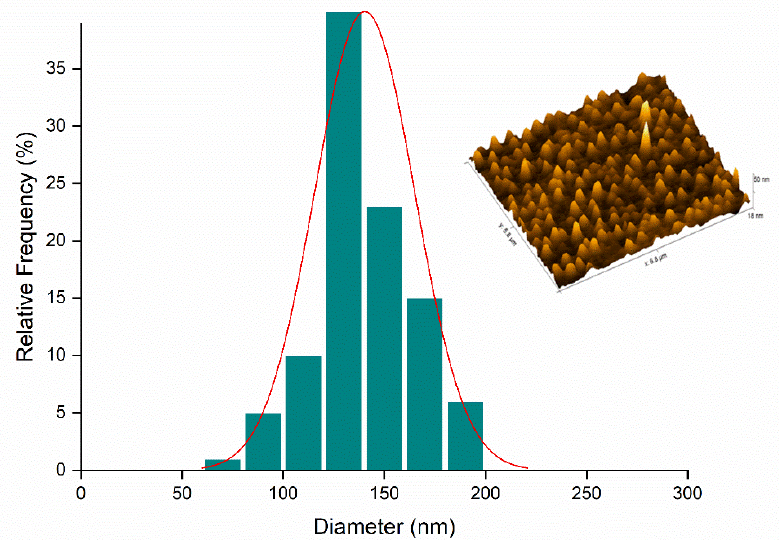
Figure 9. Representation of the size distribution graph (nm) in relation to relative frequency (%) and topography referring to the Nano_ICAR3% formulation.